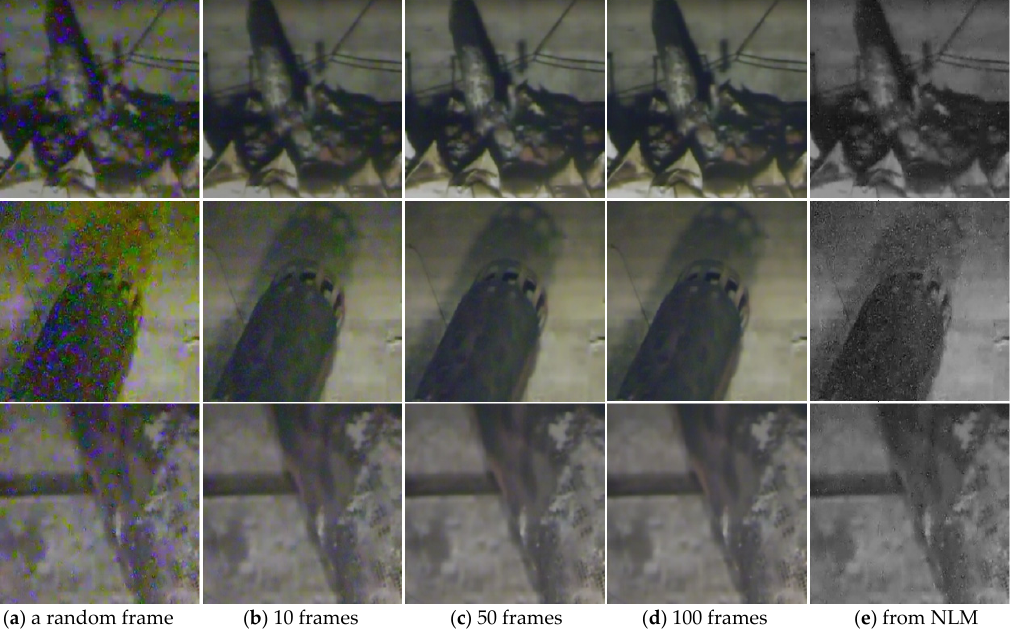
Figure 1. The averaged results and the denoised results. ( a ) Shows the original noised images randomly selected in frame sets. ( b – d ) Show the results of averaging 10, 50, 100 frames, respectively. ( e ) Shows the denoising results from the Non-local Means method (NLM).